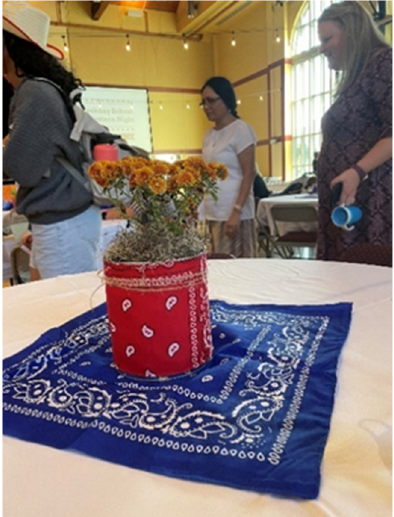
Figure 7. Sustainable centerpiece and gift using reused materials and locally sourced plant (Source: D. L. Sullins).